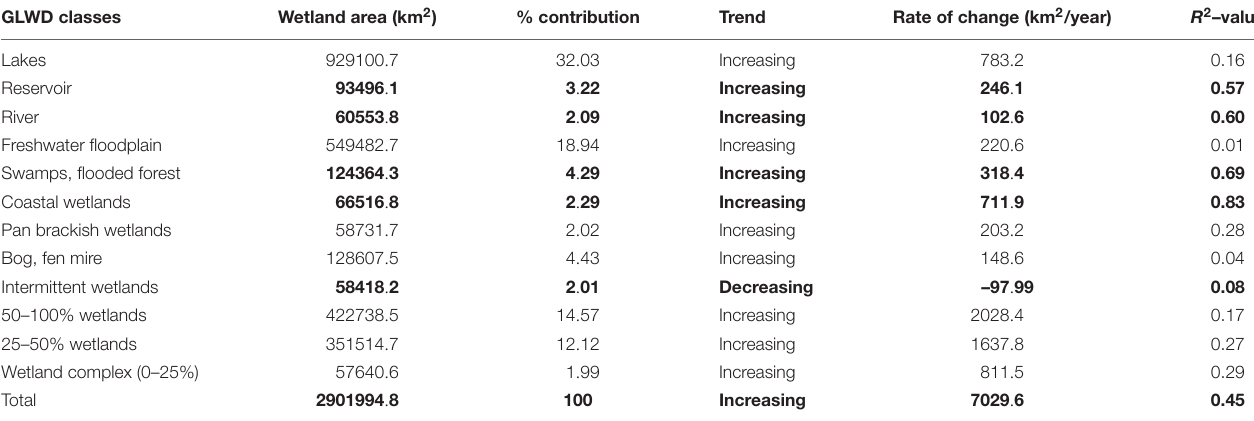
TABLE 1 | Rate of 21 years wetland area change in global lake and